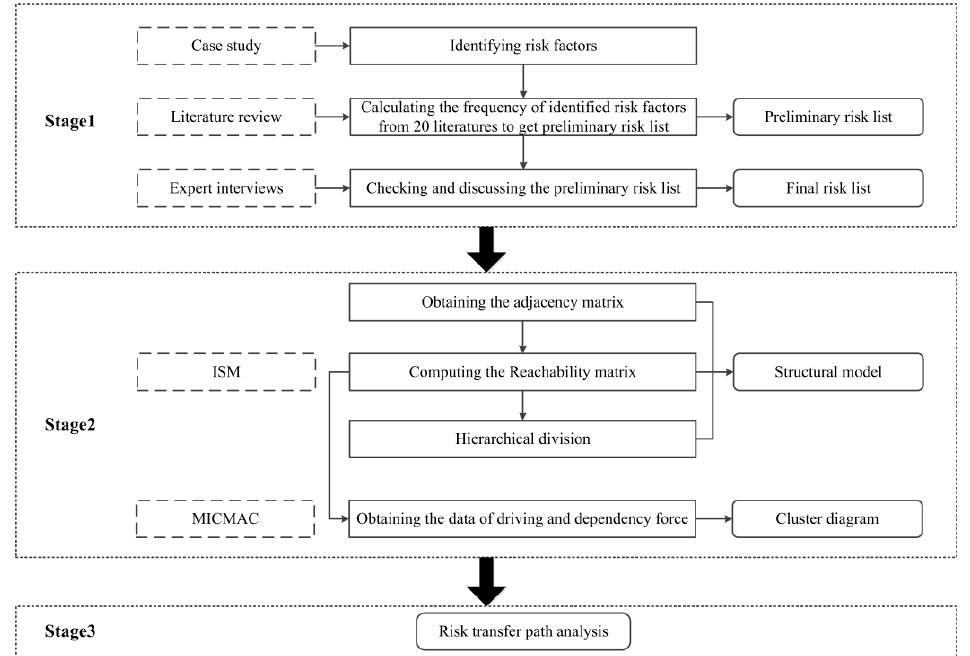
Figure 1. Research flowchart.